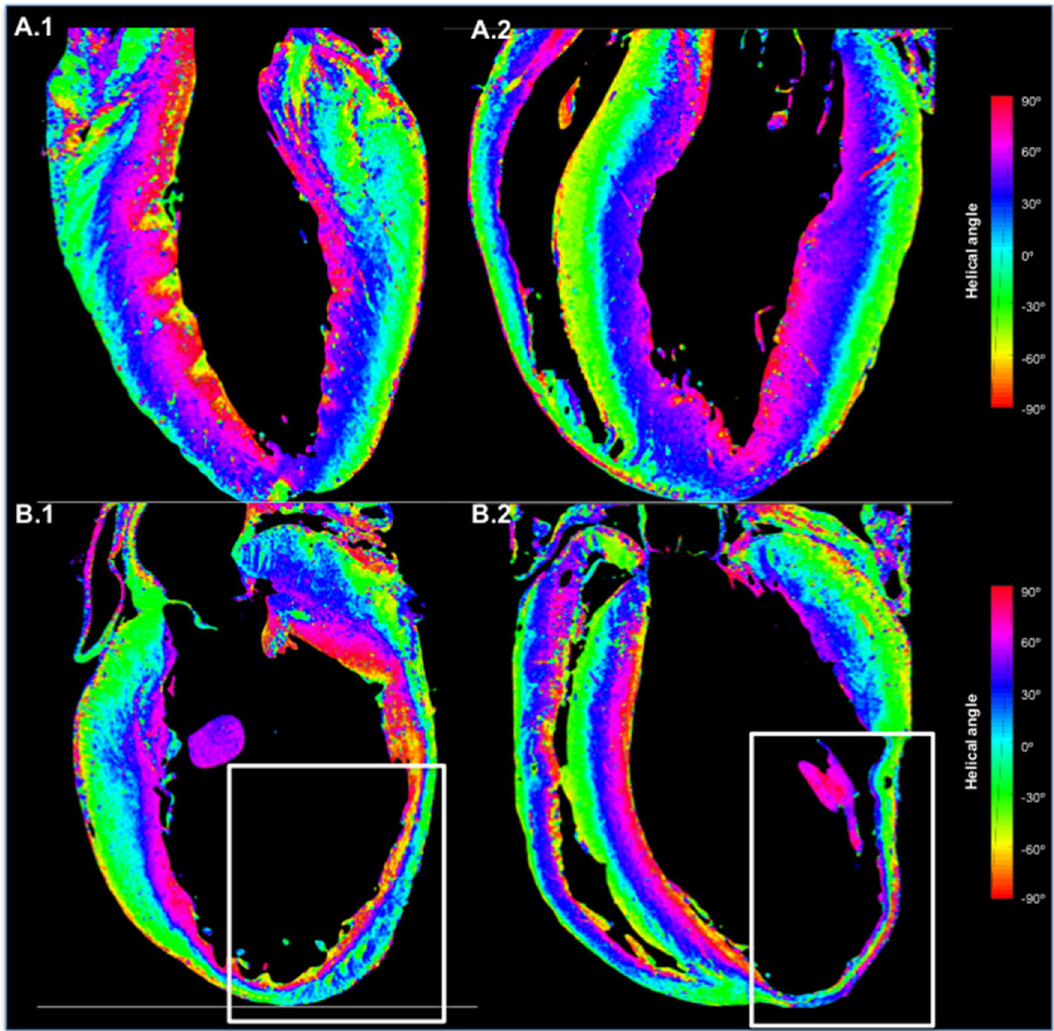
Figure 2. Longitudinal visualization of the local helical angles (HA) of myocyte aggregates. One control heart from a healthy rat, and one infarcted heart from a rat with induced myocardial infarction was used. Different colors represent different HAs. ( A.1 ) Apical 2 chamber view, and ( A.2 ) Apical 4 chamber view of the control heart. ( B.1 ) Apical 2 chamber view of the infarcted heart showing a large aneurysm of the anterior wall (white rectangle). ( B.2 ) Apical 4 chamber view of the same infarcted heart showing the apical extend of the aneurism (white